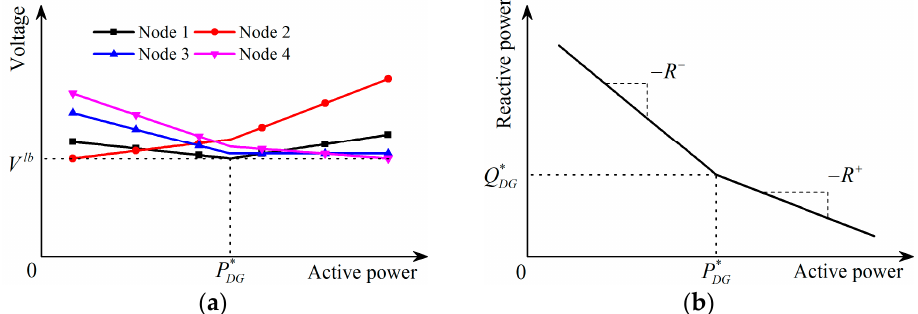
Figure 4. Voltage magnitude and reactive power variation according to active power: Proposed reactive power controller, ( a ) Voltage magnitude; ( b ) Reactive power.